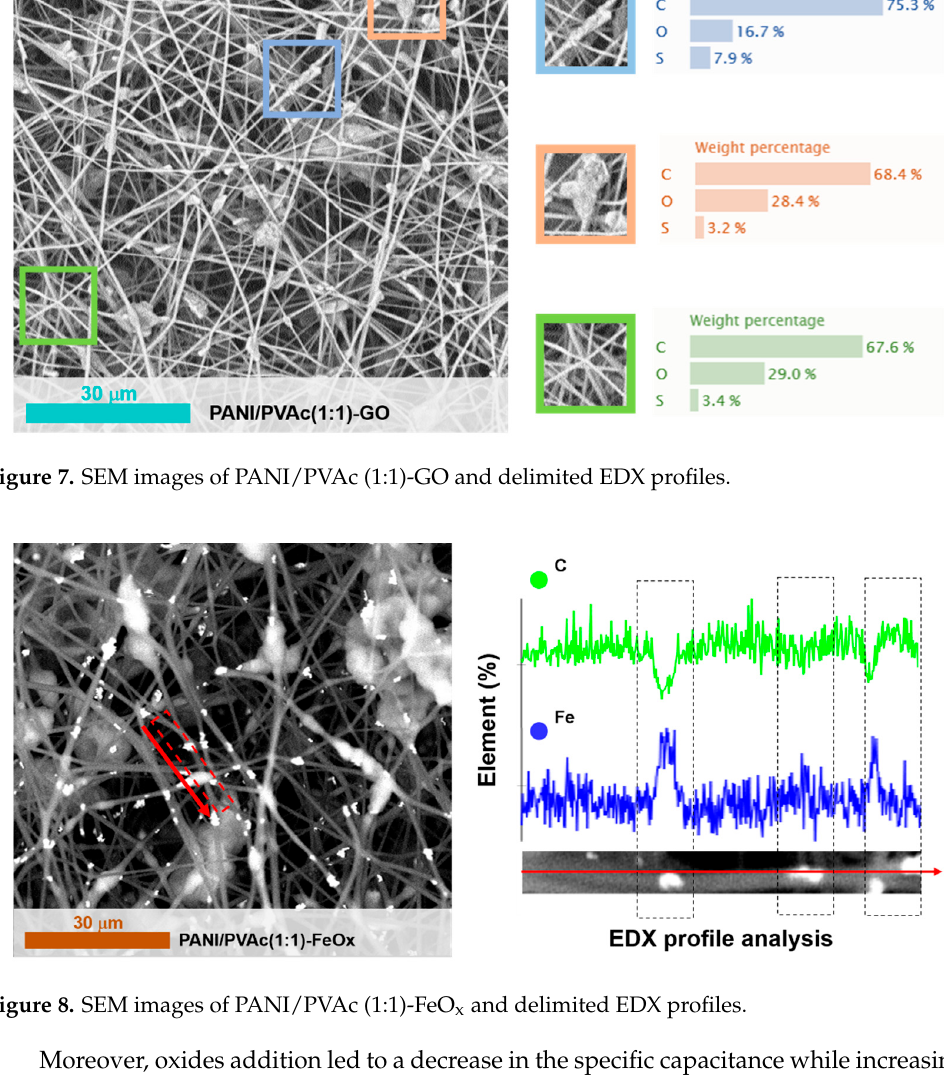
x and delimited EDX